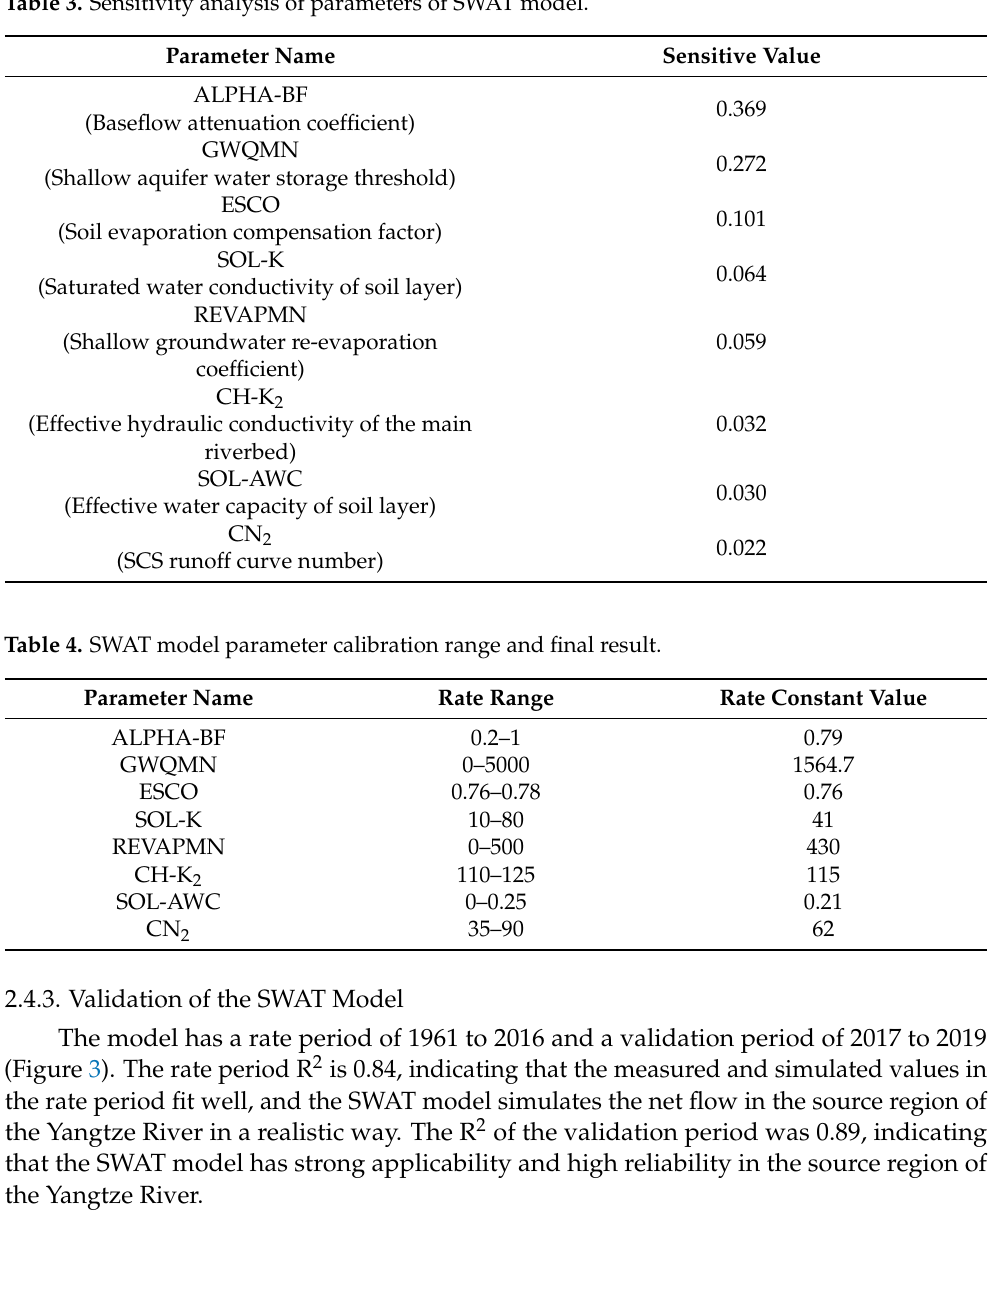
Table 3. Sensitivity analysis of parameters of SWAT model.